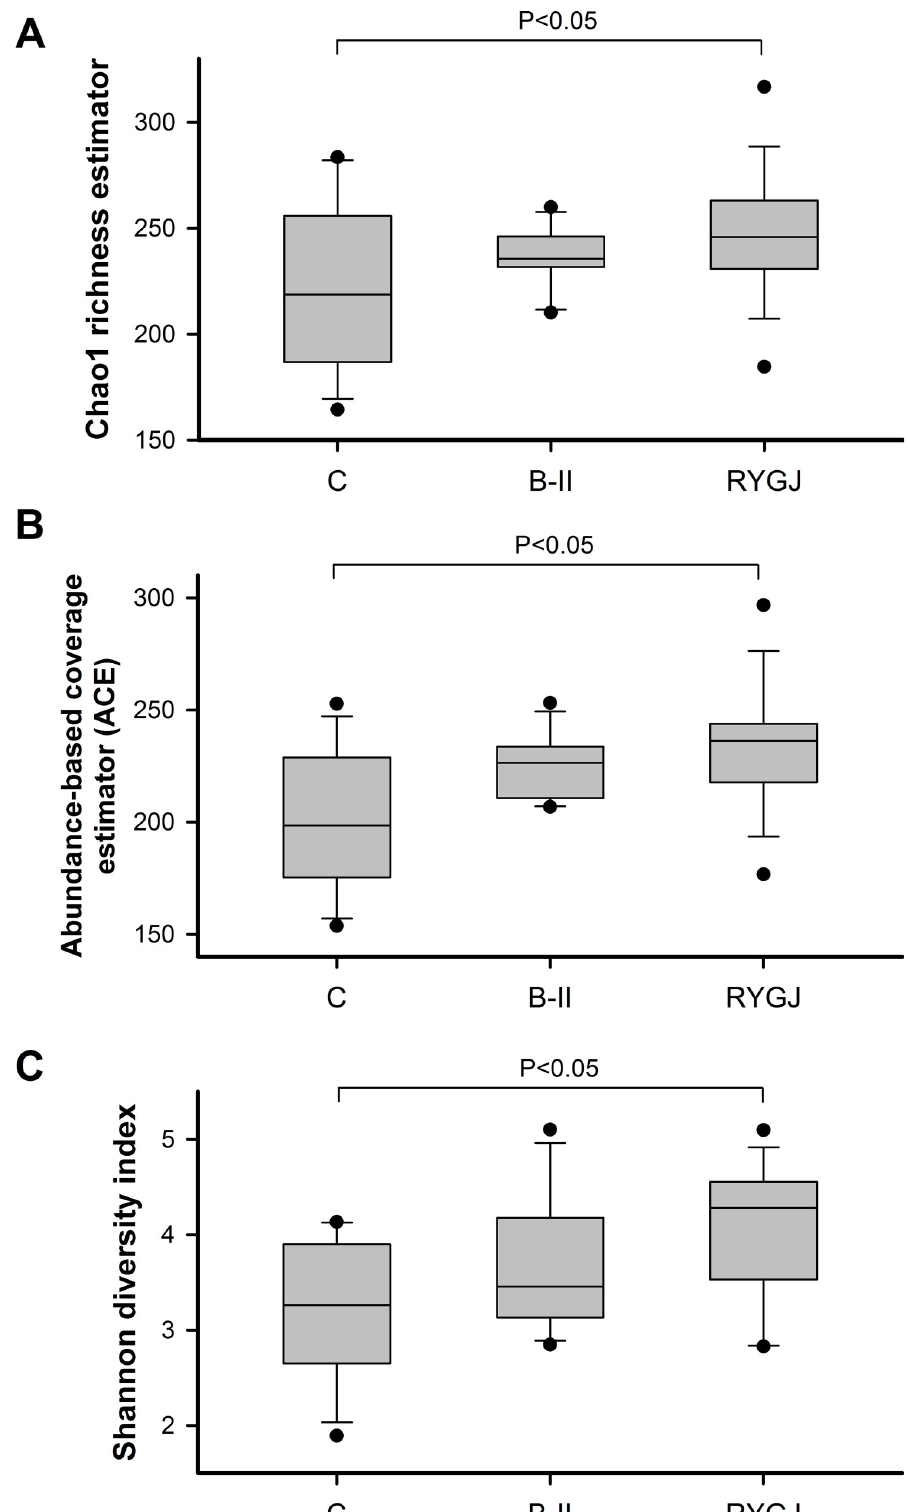
Fig 1. Richness and diversity of gut microbiota in the BII, RYGJ, and control groups. Chao1 and ACE indexes showed no significant difference in bacterial richness among B-II group and control group ( P > 0.05). Chao1 and ACE